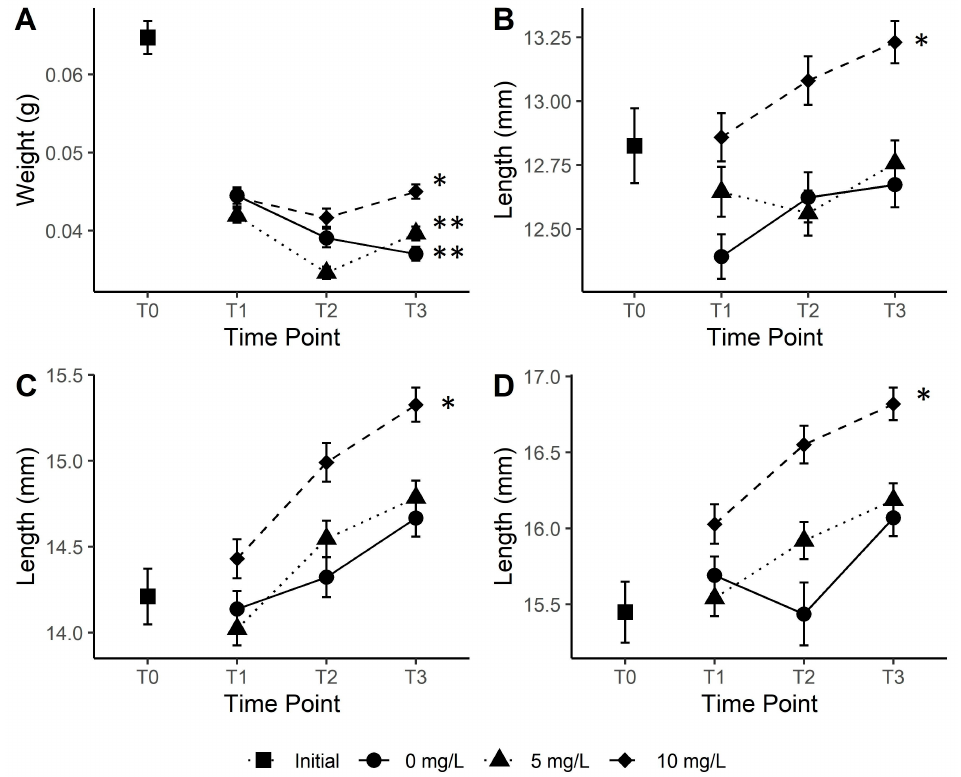
Figure 2. Weight ( A ), standard length ( B ), fork length ( C ) and total length ( D ) of juvenile Australian bass for experimental carbon treatments of 0 mg/L, 5 mg/L and 10 mg/L across the study period. Measurements of fish when acquired are presented as “Initial” measurements. Error bars represent standard error of the mean (n = 30), and asterisks (* and **) denote statistical differences in measure- ments between treatments at the end of the study. T0 = time zero–start of experiment, T1 = sampling time point 1 (2 weeks from T0), T2 = sampling time point 2 (4 weeks from T0) and T3 = sampling time point 3 (6 weeks from T0).